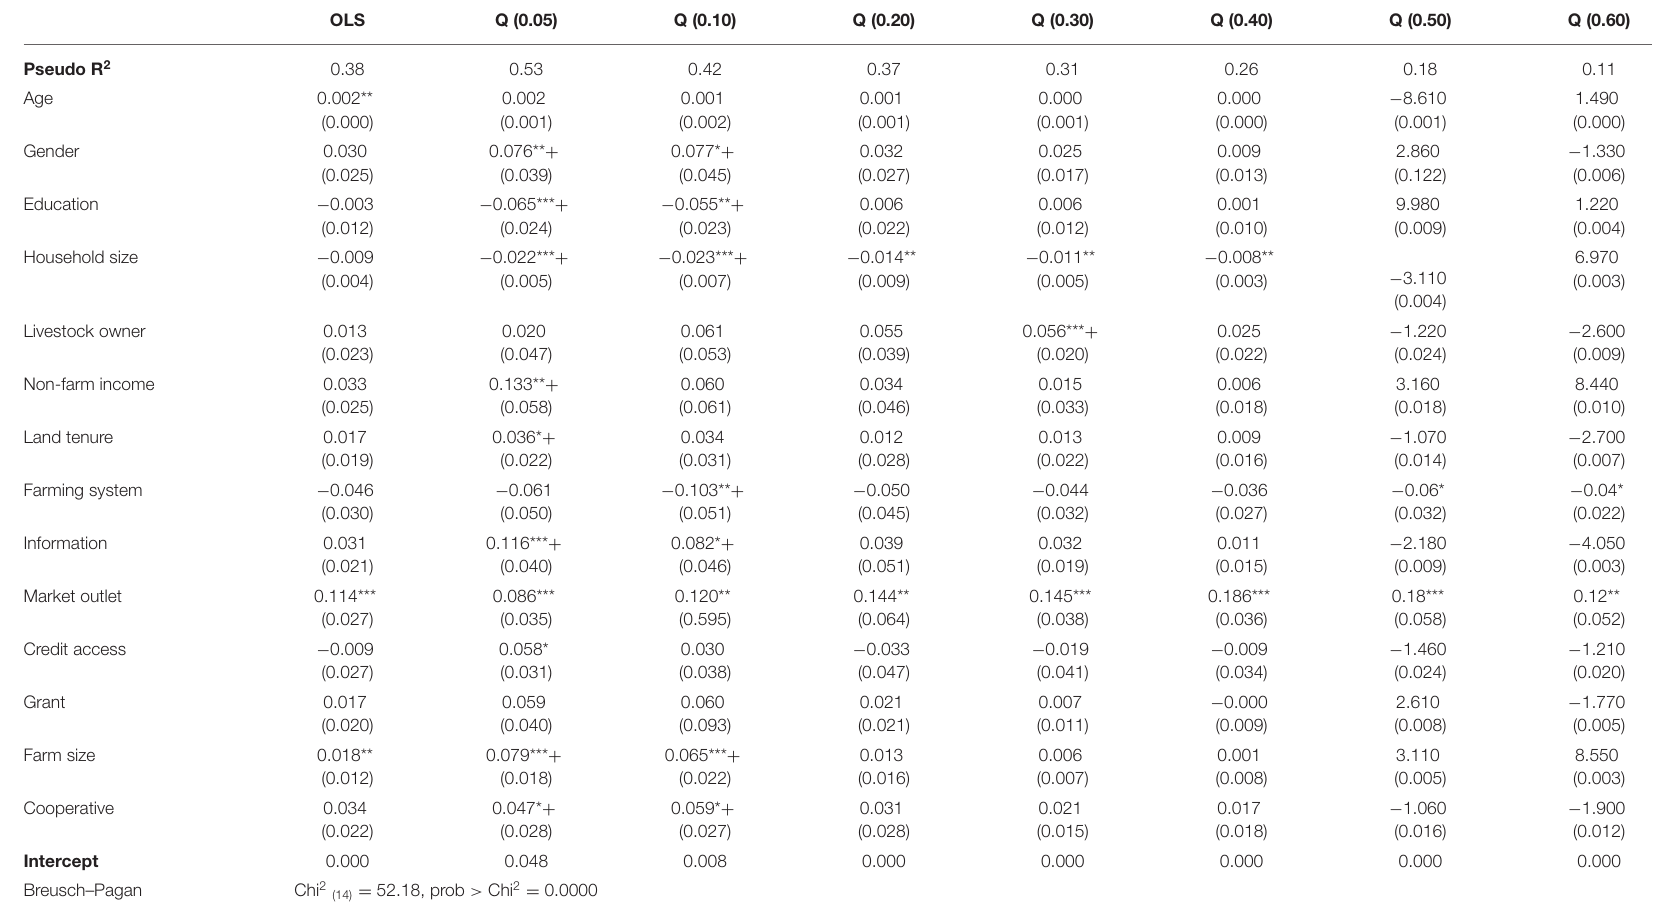
TABLE 3 | Effects of covariates using OLS and QR estimate at various